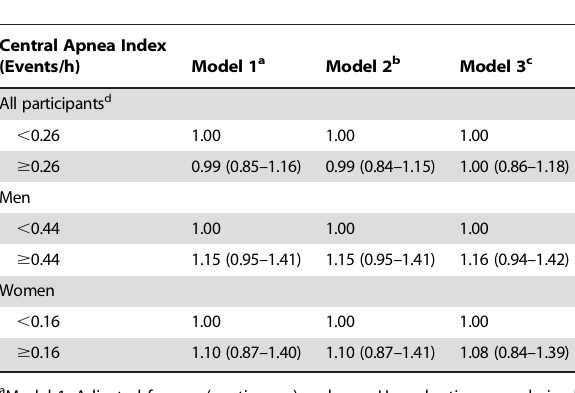
Table 4. Adjusted hazard ratios (95% confidence intervals) for the association between quartiles of arousal frequency and all-cause mortality in the Sleep Heart Health Study.